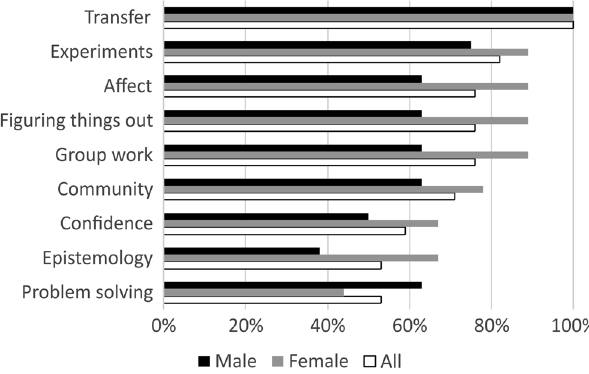
FIG. 12. Most common themes that emerged from the interview broken down by